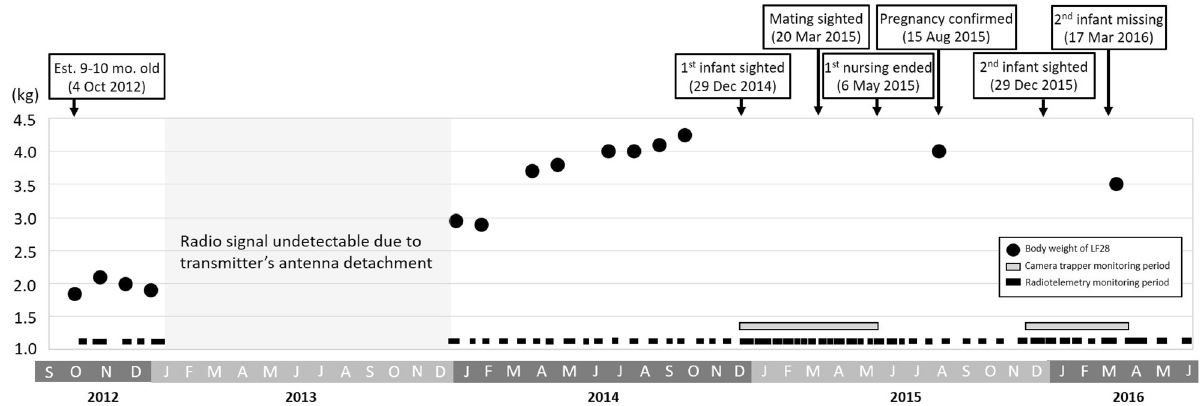
Figure 1. The tracking timeline, body mass, and reproduction records of a wild Chinese pangolin Manis pentadactyla (LF28) recorded from October 2012 to June 2016 in eastern